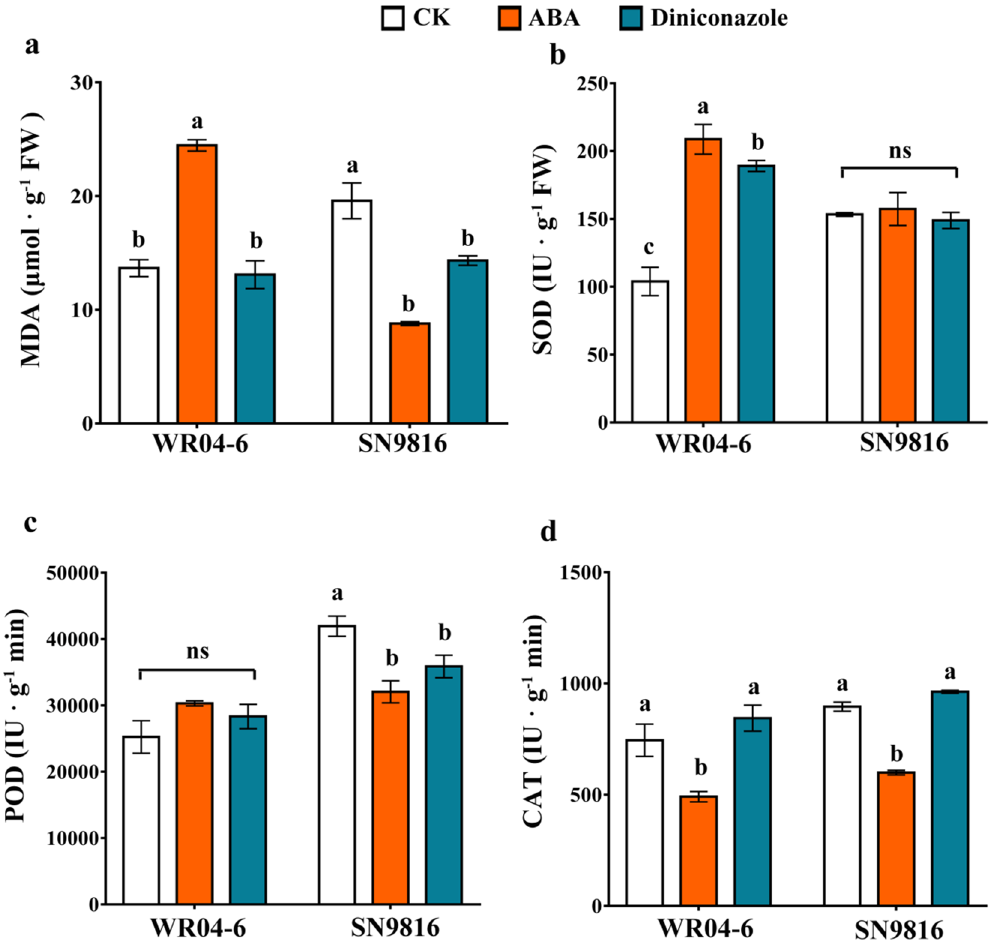
Figure 3. Evaluation of MDA concentration and antioxidant enzyme activity in WR04-6 and SN9816 seedlings after treatment with 2 μM ABA or 10 μM diniconazole. ( a ) MDA content. ( b ) SOD activity. ( c ) POD activity. ( d ) CAT activity. Error bars represent SEs (n = 3). Different letters indicate significant differences between treatments. ns indicates no difference ( p <